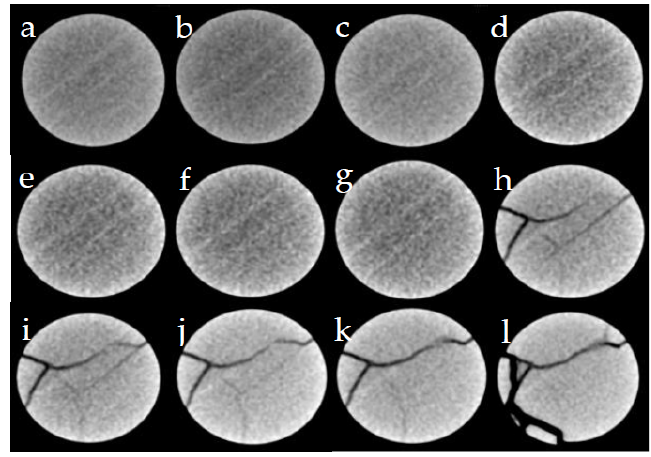
Figure 5. CT image of the fifth scan section: ( a ) σ = 0.00 MPa; ( b ) σ = 8.14 MPa; ( c ) σ = 10.30 MPa; ( d )